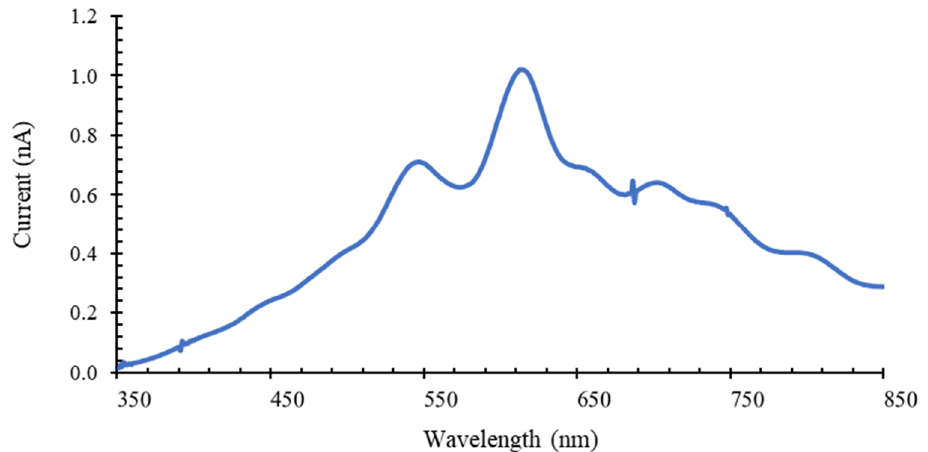
Figure 4. White light spectral current (A), emitted by the 200 W Quartz Tungsten Halogen light source and measured by a commercial photodiode, as function of wavelength (nm).